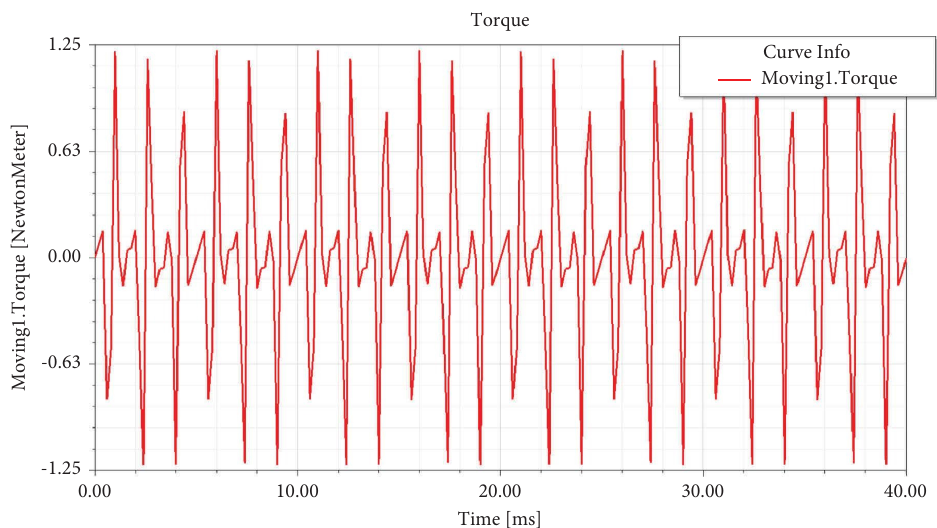
Figure 11: Reluctance torque curve of 4-pole 24-slot